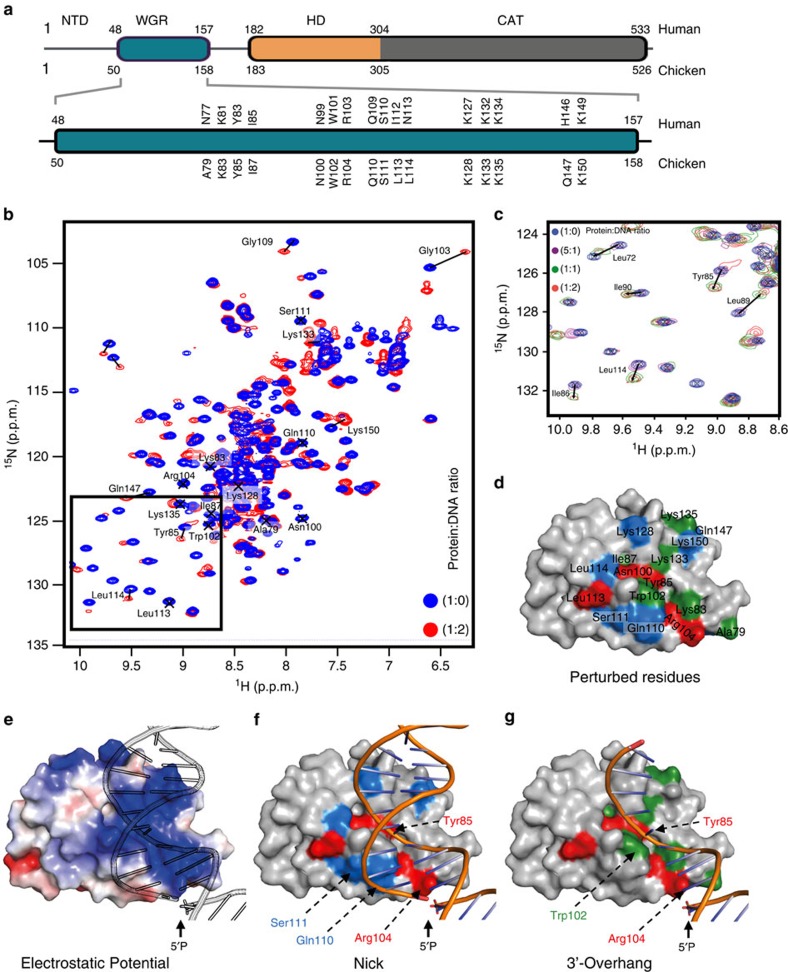
Mechanism of DNA break binding by the cPARP3 WGR domain.(a) Schematic representation of PARP3 domains with the human (top) and chicken (bottom) amino acid positions indicated. The WGR domain is shown in expanded format below showing the HSQC perturbed residues of chicken PARP3 (bottom) and the equivalent residues in human PARP3 (top). (b) Overlay of 1H–15N HSQC NMR full spectra for cPARP31–169 in the absence (blue) or presence (red) of oligodeoxyribonucleotide duplex harbouring a 5′-phosphorylated nick (protein:DNA ratios of 1:0 and 1:2, respectively). (c) Expanded view of the small boxed region shown in b demonstrating the chemical shifts induced in cPARP31–169 by different concentrations of nicked DNA. Protein:DNA ratios were 1:0 (that is, no DNA; blue), 5:1 (magenta), 1:1 (green) and 1:2 (red). (d) Map of significant chemical shifts induced in cPARP31–169 by DNA duplex harbouring a 5′-phosphorylated nick (>0.1  p.p.m) or 10-bp 3′-overhang with a recessed 5′-phosphorylated terminus (>0.04), surface modelled using CS-Rosetta41. Residues with a significant chemical shift in the presence of either a nick (blue) or 3′-overhang (green) or both (red) are indicated. (e) Electrostatic surface of modelled cPARP31–169 with nicked DNA. (f) Model of cPARP31–169 with nicked DNA, depicting residues with significant chemical shifts as above. (g) Model of cPARP31–169 with nicked DNA lacking the strand located upstream (5′) of the nick (that is, harbouring a DSB with 10-bp 3′-overhang). Residues exhibiting a significant chemical shift are indicated as above.